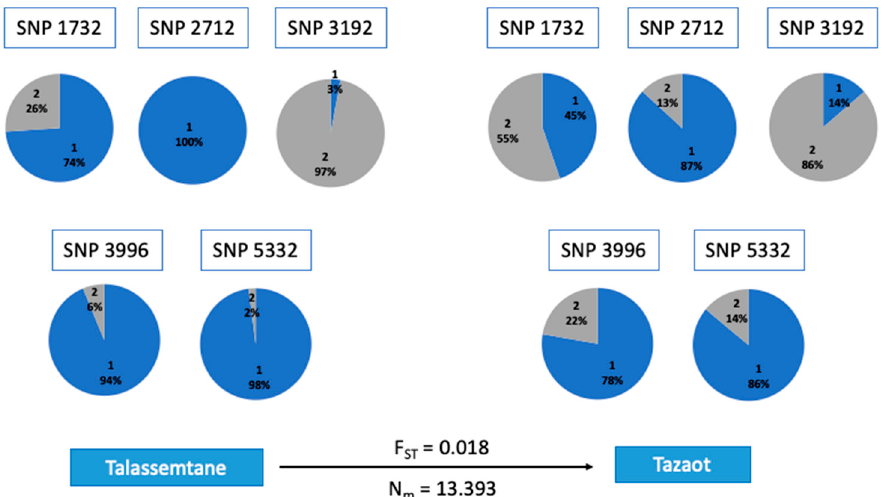
Figure 5. SNPs that showed associations with dendrophenotype variables, specifically with DBH (SNP 1732) and CV BAI 1900–2018 (SNP 2712, SNP 3192, SNP 3996, SNP 5332). The percentage of each allele is shown: blue for the reference allele and grey for the alternative. The fixation index (F ST ) and migration rate (Nm) between the two sites are indicated above and below the arrow. The 4-digit number used as ID for the SNPs indicates the position in our genetic matrix. Table 4. Dendrophenotypic traits used in the genotype–phenotype associations (GPA) to relate tree- level growth patterns and climate sensitivity with the single nucleotide polymorphisms (SNPs) ob- tained.